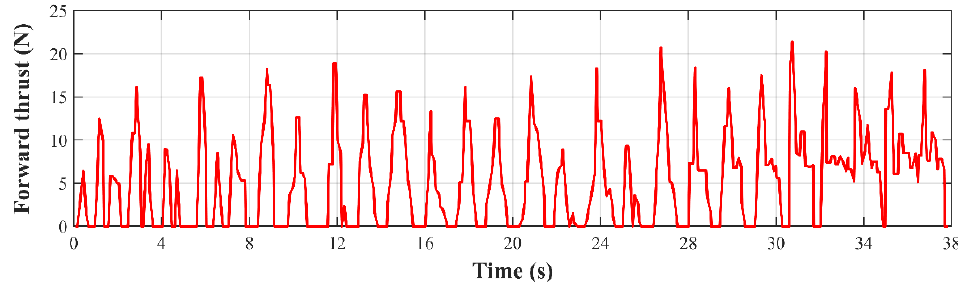
Figure 11. The forward thrust of the pair of hydrofoils obtained by the experiment. The comparison of the tank experiment and numerical simulation is shown in Table 5.